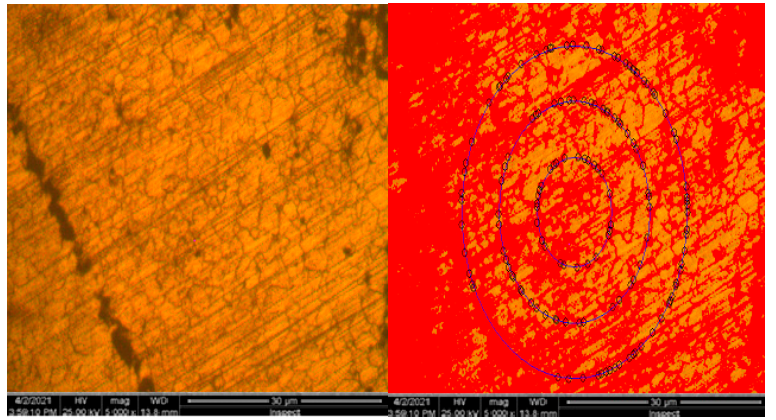
Figure 11. Microscopic appearance of austenitic grains for the forged semi-finished product 42CrMo4 [1].